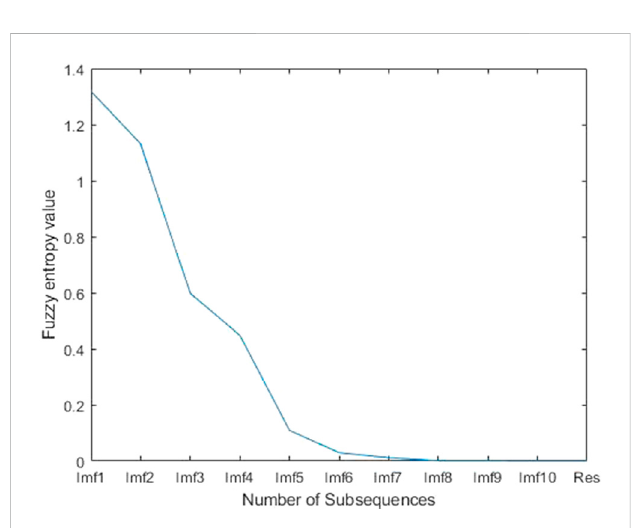
FIGURE 7 Fuzzy entropy analysis of the decomposition results of Case